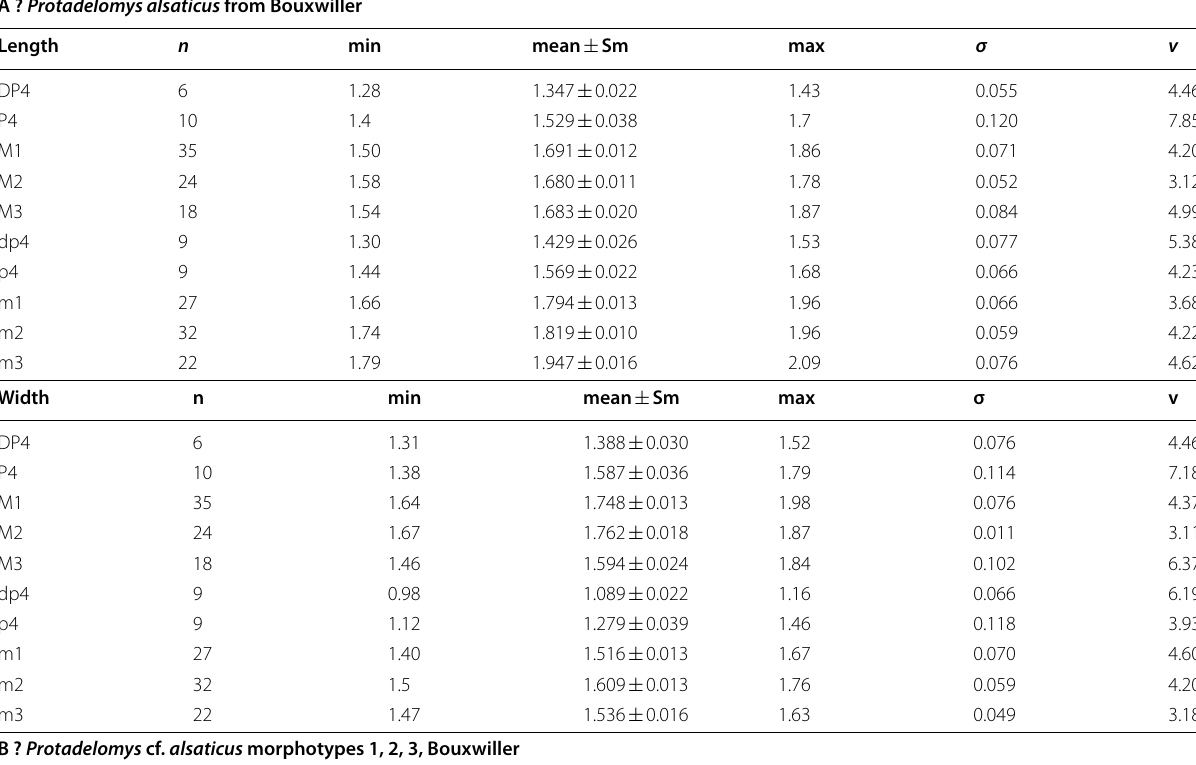
Table 4 Range of the size variations (length and width: min., max.; average loci of teeth of ? Protadelomys alsaticus Hartenberger, 1969 and B. length and width for some loci only of ? Protadelomys cf. alsaticus